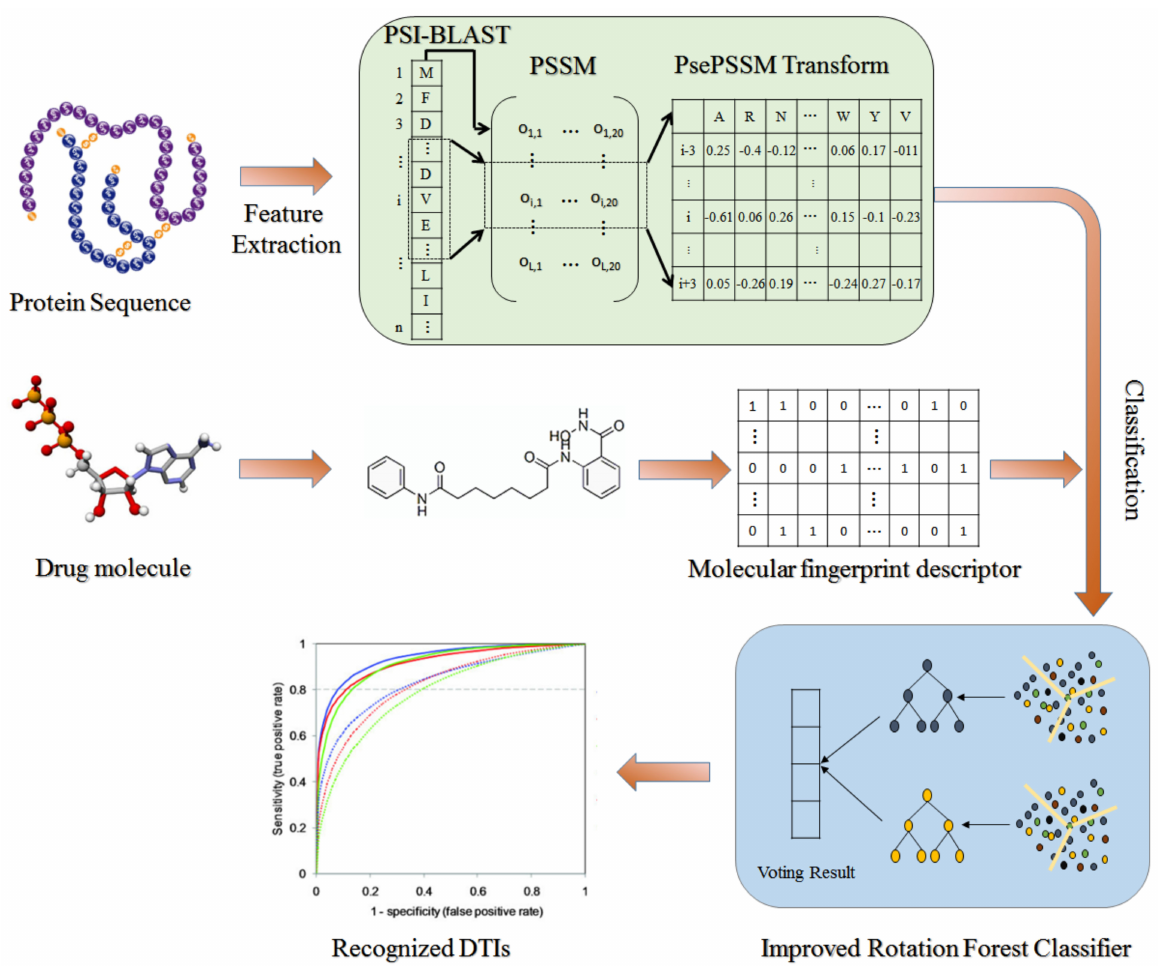
Figure 1. Flow framework diagram of RoFDT